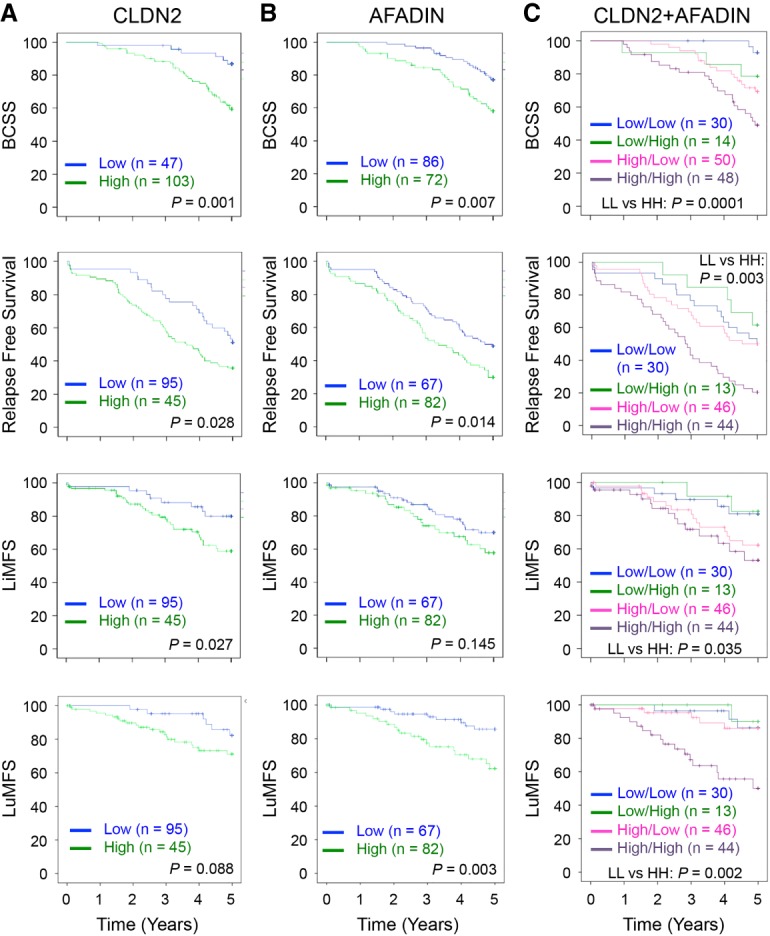
Claudin-2 and Afadin are prognostic of breast cancer liver metastasis. Kaplan-Meier analysis of metastatic breast cancer patients divided into high (green) and low (blue) reveals that expression of either Claudin-2 (A) or Afadin (B) is prognostic for BCSS and RFS. Claudin-2 expression is also prognostic of LiMFS (A), while Afadin expression is prognostic of LuMFS (B). (C) Further prognostic value is observed when considering Claudin-2low/Afadinlow (blue), Claudin-2low/ Afadinhigh (green), Claudin-2high/Afadinlow (pink), and Claudin-2high/Afadinhigh (purple) cohorts. (+) Censored.